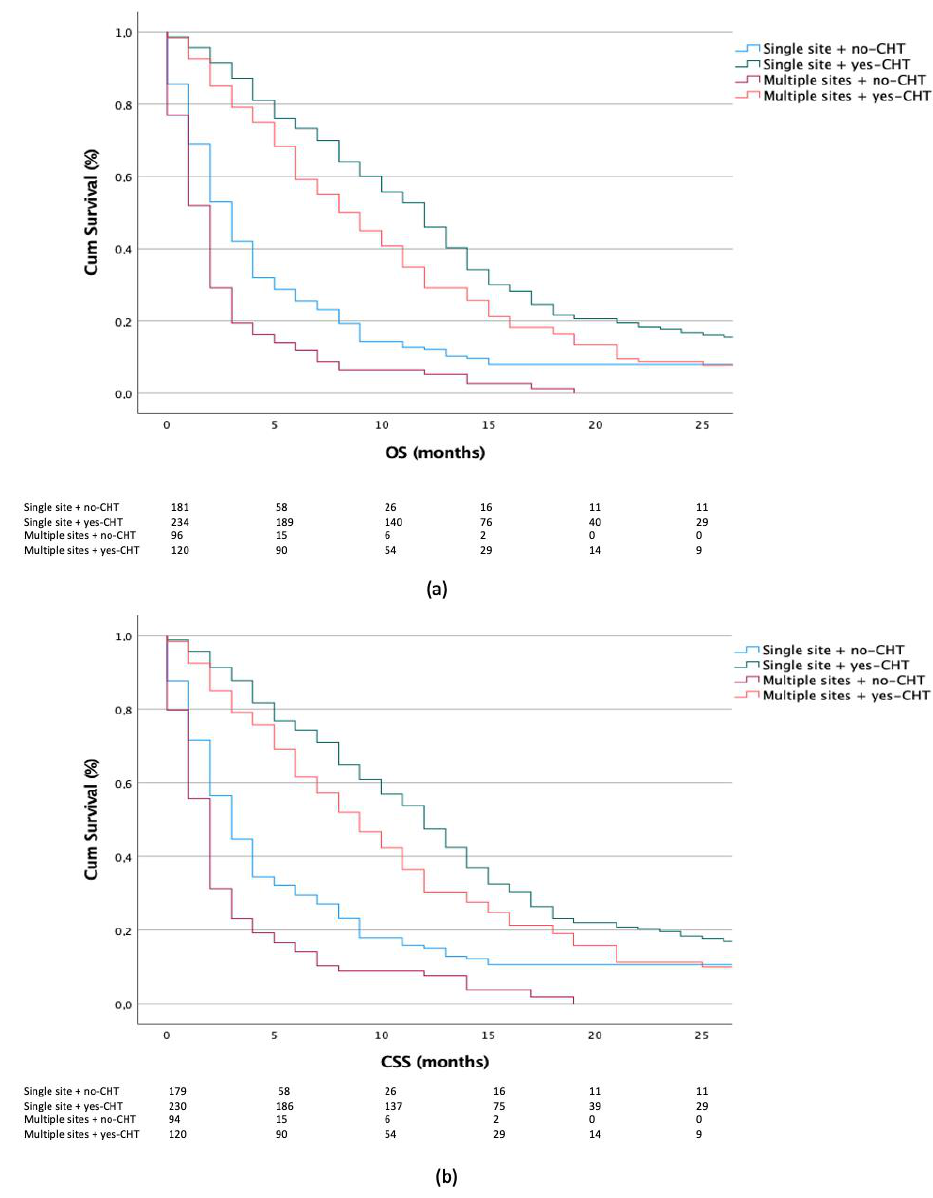
Figure 3. Kaplan – Meier plots depicting OS ( a ) and CSS ( b ) according to chemotherapy (CHT) ad- Figure 3. Kaplan–Meier plots depicting OS ( a ) and CSS ( b ) according to chemotherapy (CHT) ministration in patients with single- vs. multiple-organ metastases. administration in patients with single- vs. multiple-organ